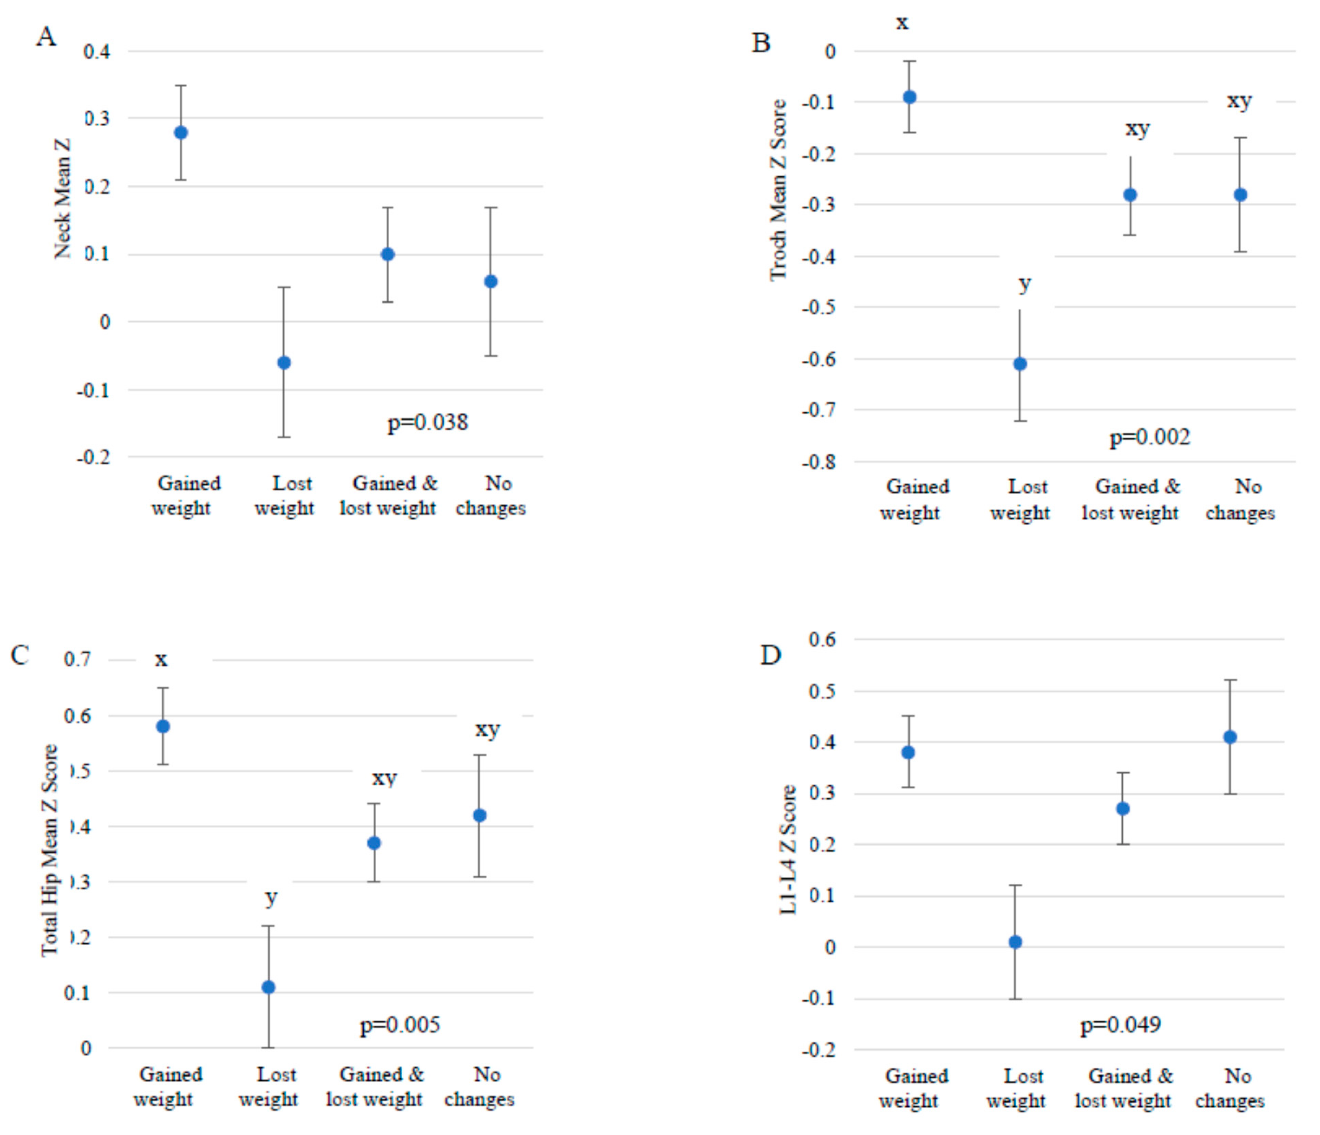
Figure 3. Weight change trend during 18-month study period of interest and mean ± standard error BMD at each measurement site. ( A – D ), Gained weight n = 176; Lost weight n = 80; Gained and lost weight n = 172; No changes n = 79. Columns with different XY indicate p < 0.0125 (Tukey-Kramer).